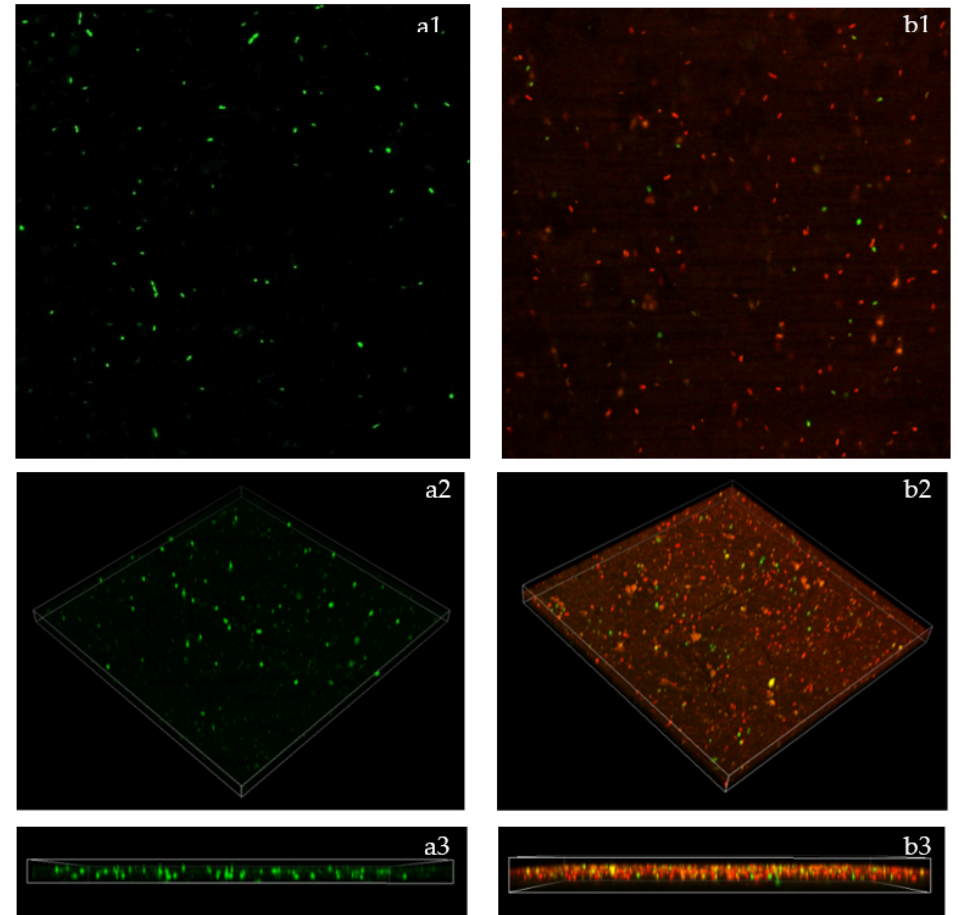
Figure 6. Confocal laser scanning microscope analyses were performed after 24 h treatment period. ( a1 ) The green color of untreated Bg cells indicated that the cells were alive and undamaged. ( b1 ) The image displays orthogonal 3D biofilm untreated Bg cells. ( a2 , a3 ) GEO treatment of Bg cells MIC resulted in red-stained cells, indicating that more dead cells occurred. ( b2 , b3 ) The image displays orthogonal 3D biofilm GEO treatment of Bg